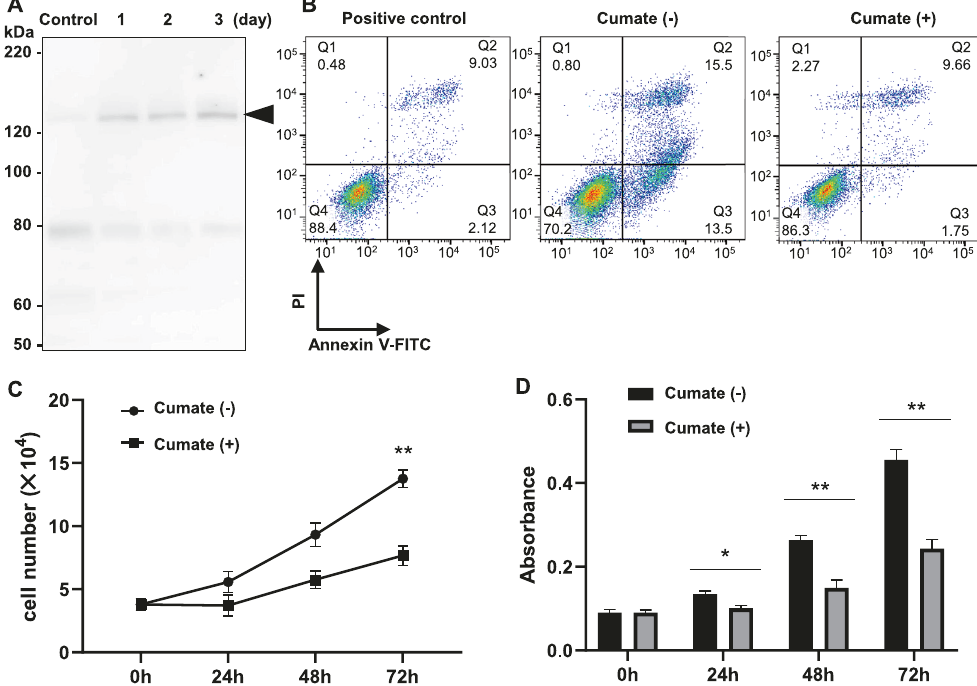
Fig. 2 Effects of drug-induced expression of POTEF protein in HGrC1 cells. A Western blotting with anti-Flag antibody. In the HGrC1 cell line with a chemical inducible expression vector for POTEF tagged with Flag (CuO-POTEF-Flag HGrC1), POTEF protein (arrowhead) was detected for 3 days when the cumate chemical solution was present. B Apoptosis of CuO-POTEF-Flag HGrC1 cells treated with or without cumate treatment for 72 h, stained with fl uorescein isothiocyanate (FITC)-conjugated annexin V, and analyzed using fl ow cytometry. Positive control refers to the rate of apoptosis in HGrC1 cells cultured without serum for 72 h. C Analysis of the number of CuO-POTEF-Flag HGrC1 cells counted every 24 h, with or without cumate treatment. D Bromodeoxyuridine (BrdU) proliferation assay of CuO-POTEF-Flag HGrC1 cells with or without cumate treatment. The incorporation of BrdU was measured using an ELISA system. Data are presented as means ± SD. Three independent experiments showed similar results. * P < 0.05 and ** P < 0.01 with vs without cumate